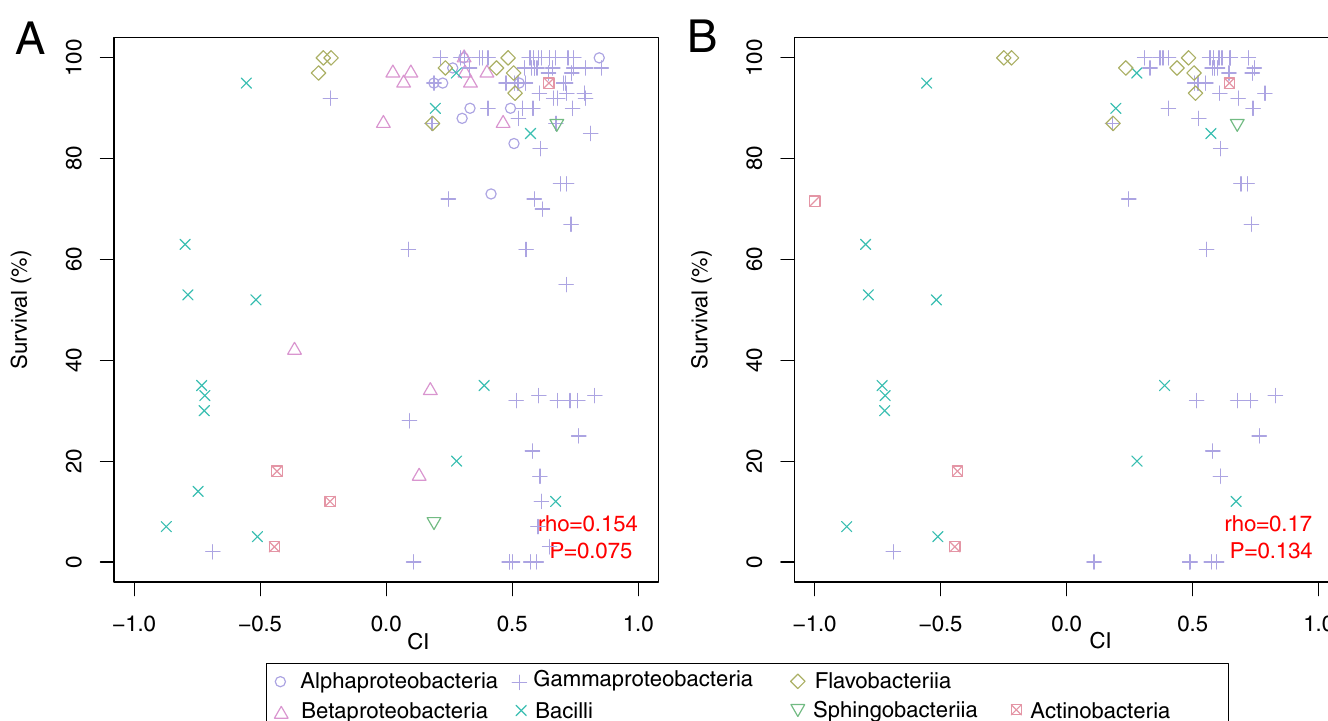
Fig 5. Correlation between survival and chemotaxis. (A) Testing for the correlation between survival and chemotaxis data we found a weak trend (Spearman’s rho = 0.154, P = 0.075) for bacteria resulting in higher survival rates to also have higher chemotaxis indices, compared to strains that do not support growth or are pathogenic. (B) Similar correlation tests for those bacterial strains isolated from beetles where again, no strong signal was observed (Spearman’s rho = 0.17, P = 0.134).